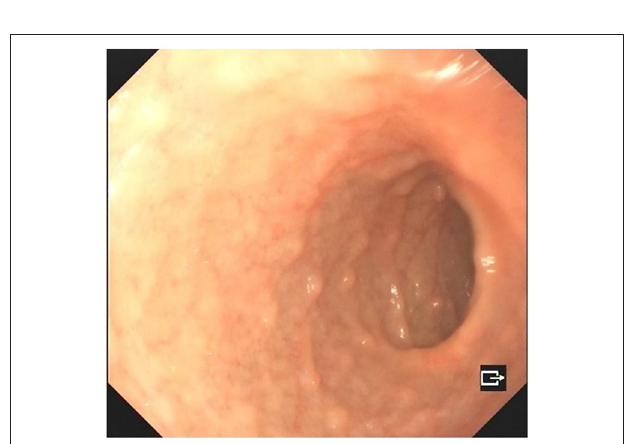
FIGURE 2 | Esophagogastroduodenoscopy showed multifocal raised nodules in the duodenal bulb.